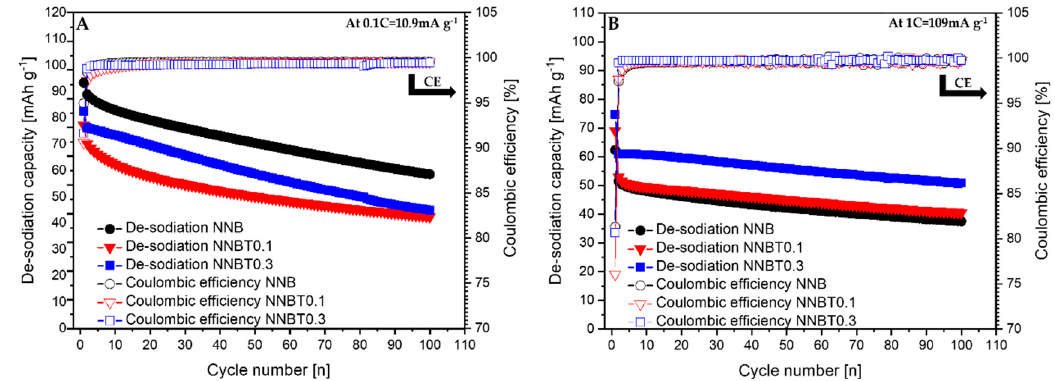
Figure 5. De-sodiation curves of NNB, NNBT0.1 and NNBR0.3 with their corresponding coulombic efficiency at 0.1 C ( A ) and 1 C ( B ).